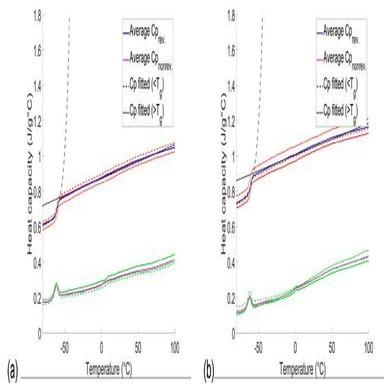
MDSC results for (a) F-NR4, (b) F-NR5 with model fits either side of Tg.